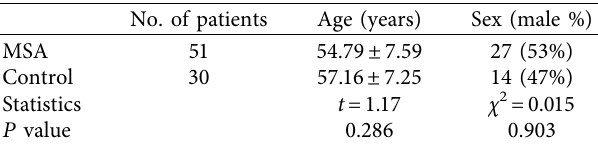
Table 1: Comparison of general information between MSA and control